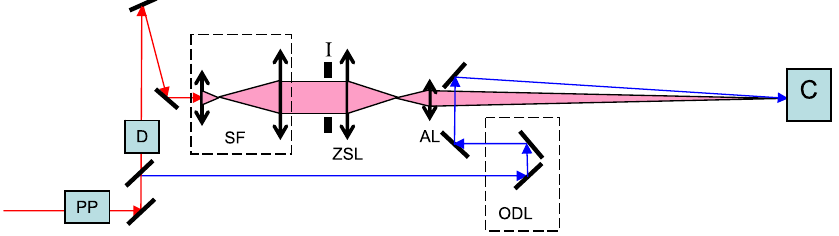
FIG. 7. (Color) Schematic of the experiment. PP: pulse picker; D: DAZZLER; SF: achromatic spatial filter; ZSL: ZnSe lens; AL: achromatic image relay lens; ODL: optical delay line; C: camera. I: iris.